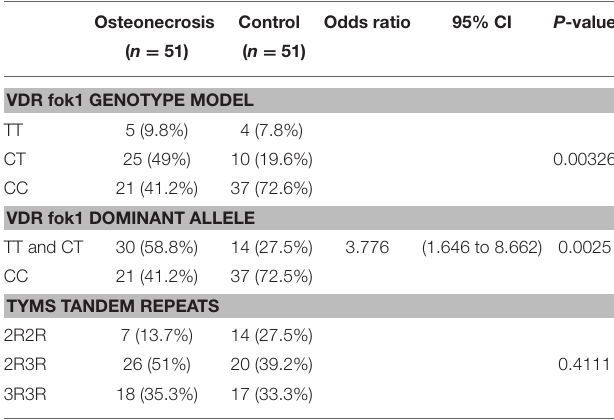
TABLE 2 | VDR fok1 and TYMS tandem repeats in cases with osteonecrosis vs. controls ( N = 102). Osteonecrosis Control Odds ratio